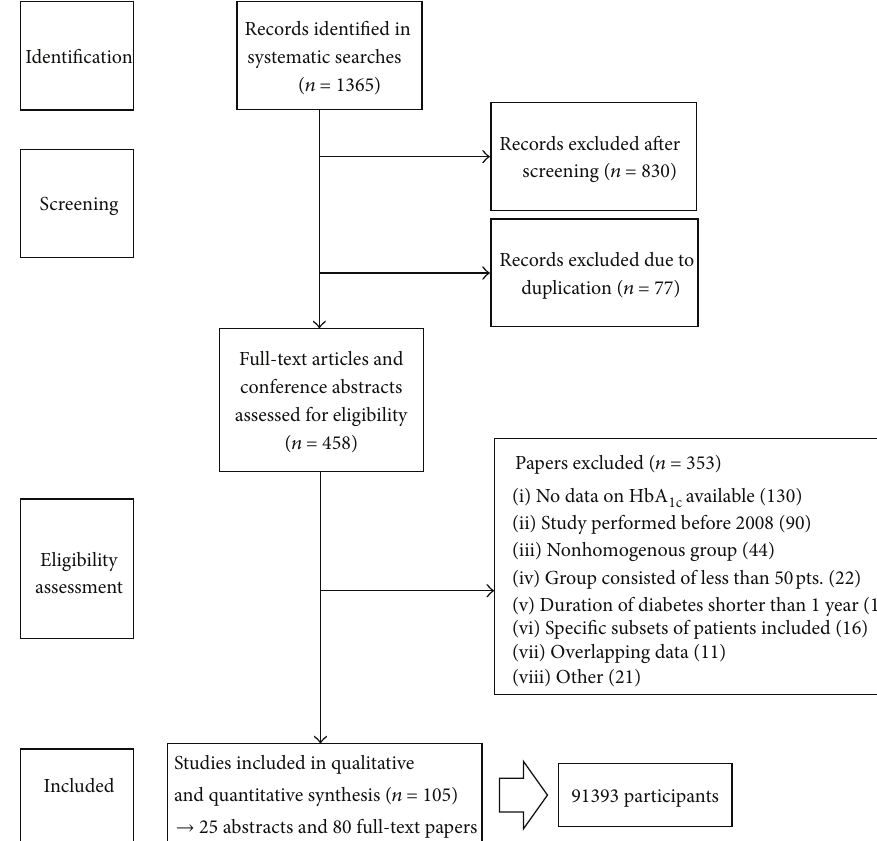
Figure 1: Flowchart for studies’ selection